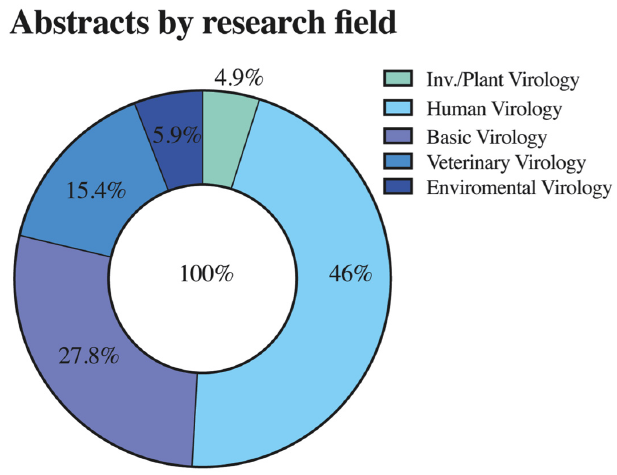
Figure 3. Abstracts presented at the 33rd SBV Annual Meeting, distributed by their interest area.